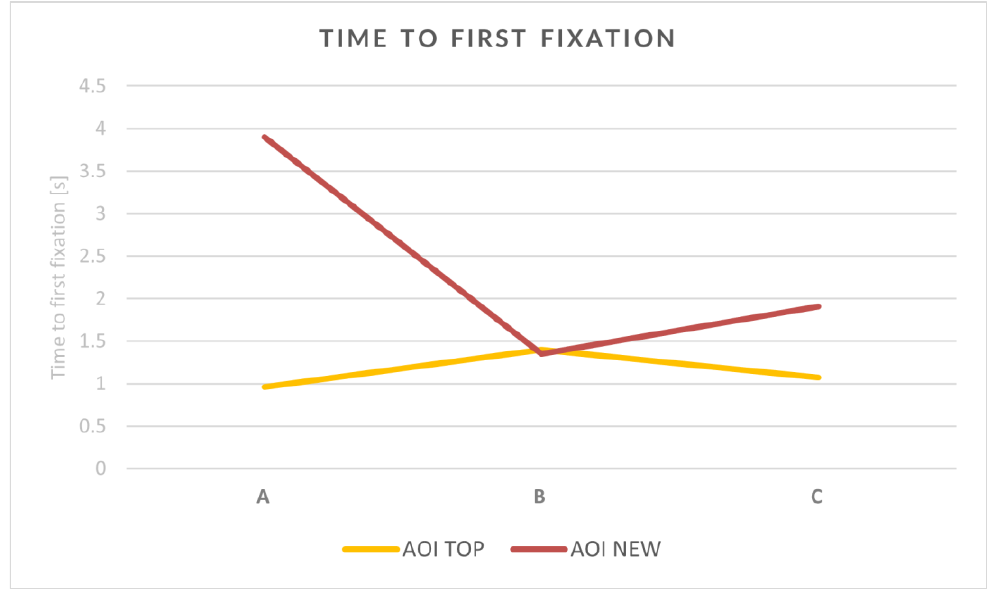
Figure 8. Time to first fixation (TTFF) comparison.